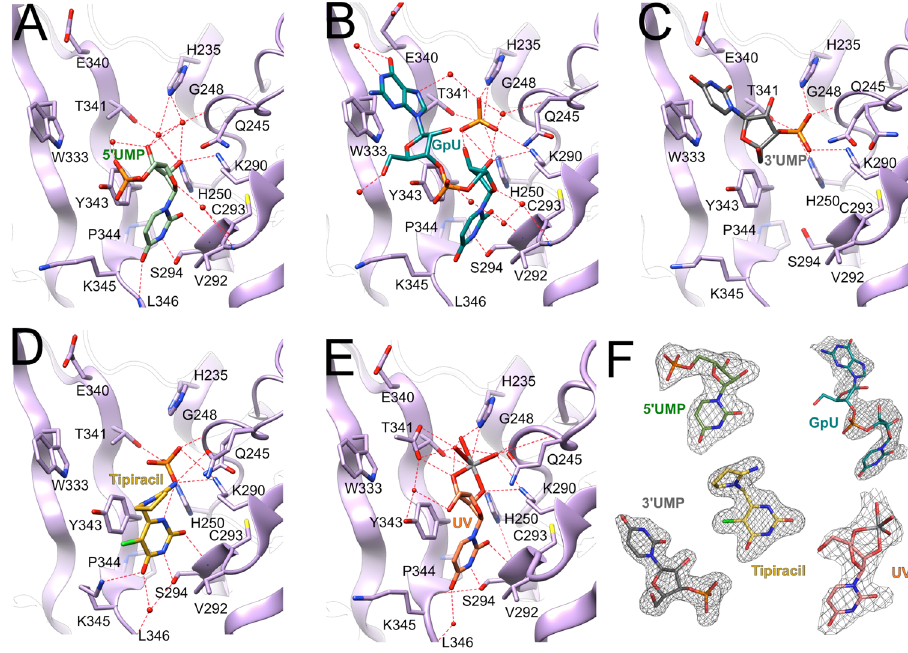
Fig. 4 The structures of Nsp15 endoribonuclase with bound ligands. A 5 ′ UMP in light green, B 5 ′ GpU in teal, C 3 ′ UMP in gray, D Tipiracil in yellow, and E uridine 2 ′ ,3 ′ -vanadate in light coral. Phosphate ions are in orange/red. F Ligands electron density omit maps contoured at 3.2 σ except for the map for GpU which was contoured at 2.5 σ